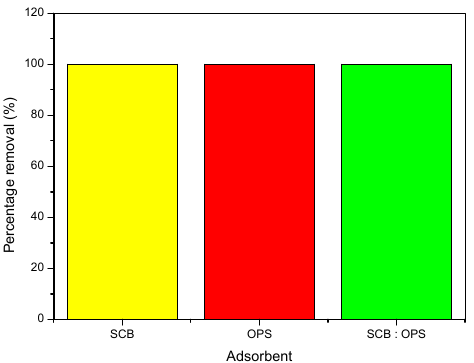
Figure 15. Effect of real water sample matrix on 10 mg/L Pb(II) percentage removal.